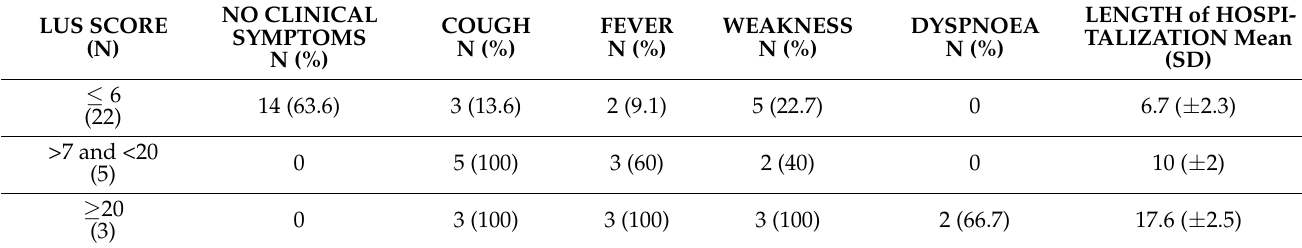
Table 2. Characteristics of patients’ symptoms, length of hospitalization according to LUS score.